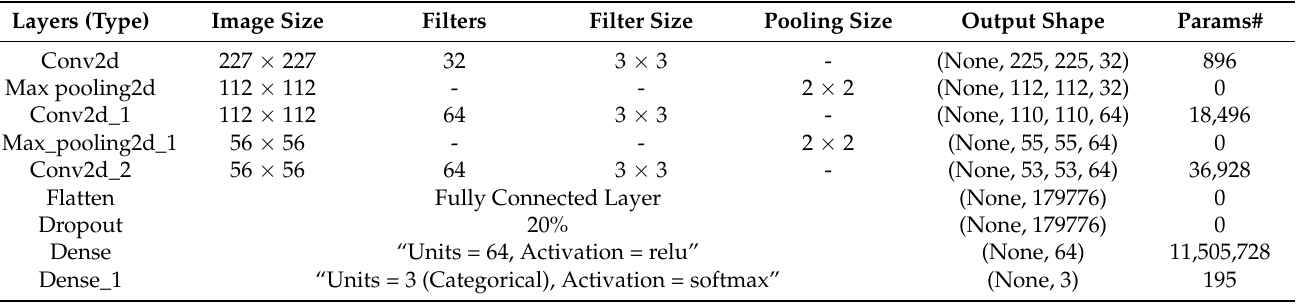
Table 3. The proposed CNN model architecture.